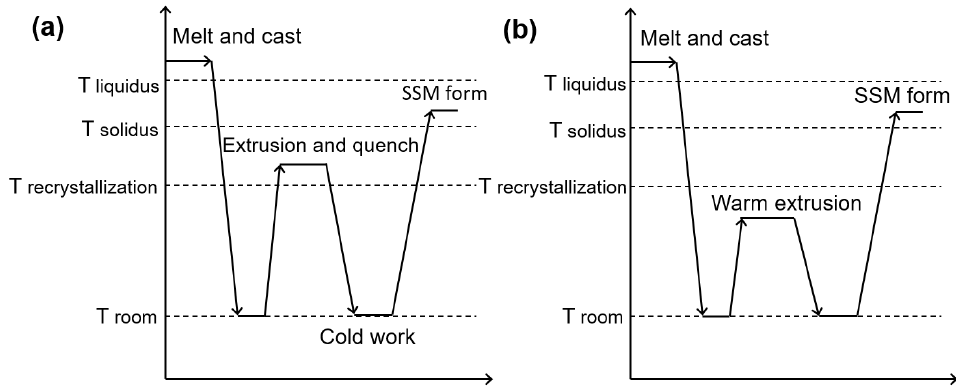
Figure 15. Comparison of ( a ) SIMA and ( b ) RAP [151,153]. T denotes temperature.